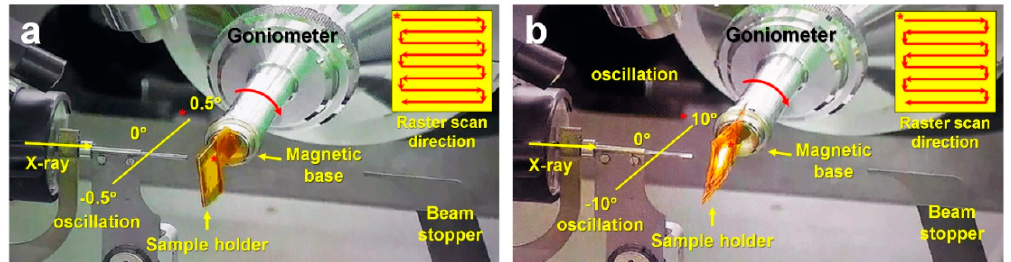
Figure 2. Data collection from FT-SSX using two different approaches. ( a ) Raster-scanning data collection for 100 ms X-ray exposure with 0.011° oscillation. The total oscillation angle in the horizontal direction was 1°. ( b ) Raster-scanning data collection for 500 ms X-ray exposure with 0.222° oscillation. The total oscillation angle in the horizontal direction was 20°.The rotation direction of goniometer is indicated by red arrows. The raster scanning direction is shown in the right panel. The asterisk indicates the starting point of the raster scan.